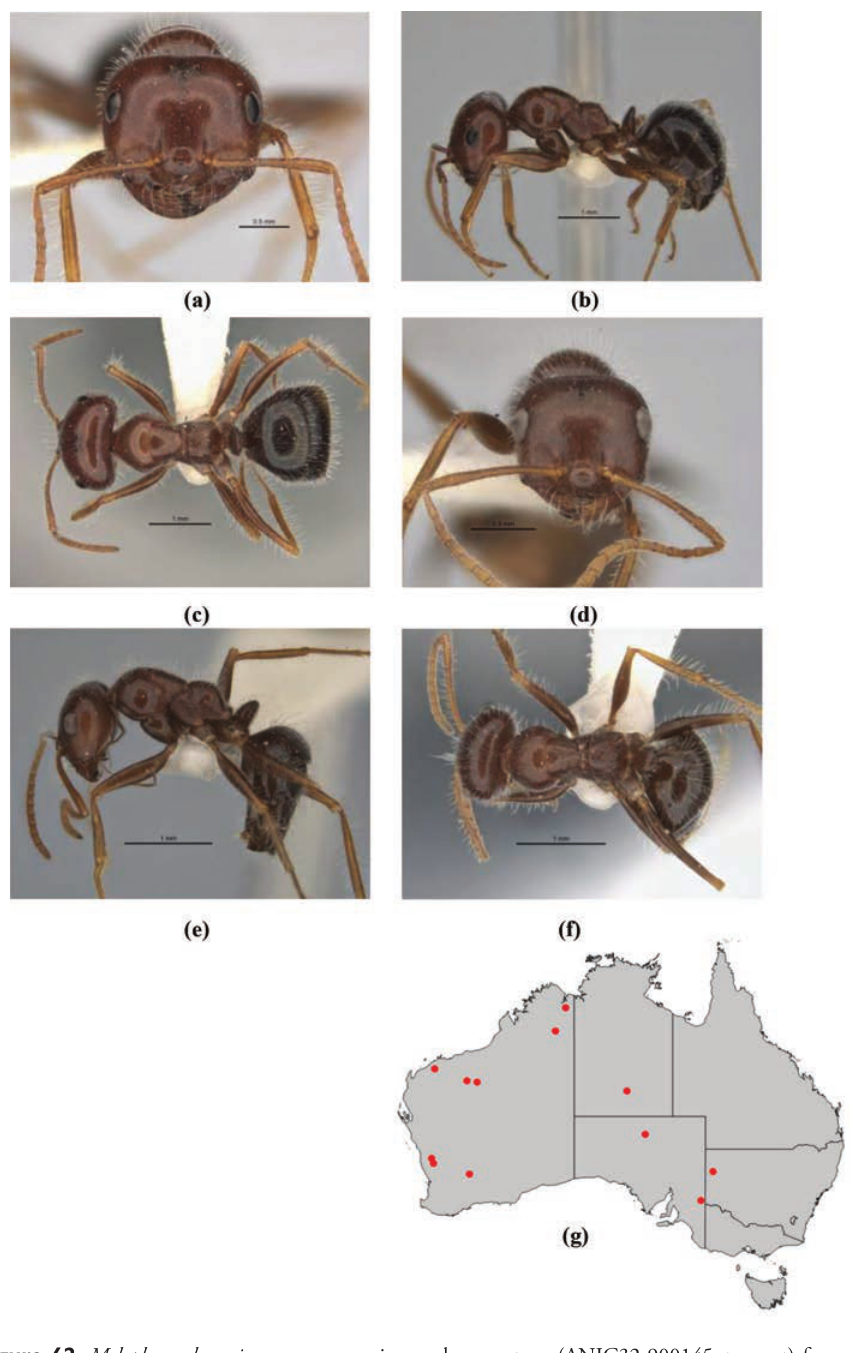
Figure 62. Melophorus lanuginosus sp. n.: major worker paratype (ANIC32-900145–top ant) frons ( a ), profile ( b ) and dorsum ( c ); minor worker holotype (ANIC32-900145–bottom ant) frons ( d ), profile ( e ) and dorsum ( f ); distribution map for the species ( g ). Low resolution scale bars: 1 mm ( b, c , e, f ); 0.5 mm ( a, d